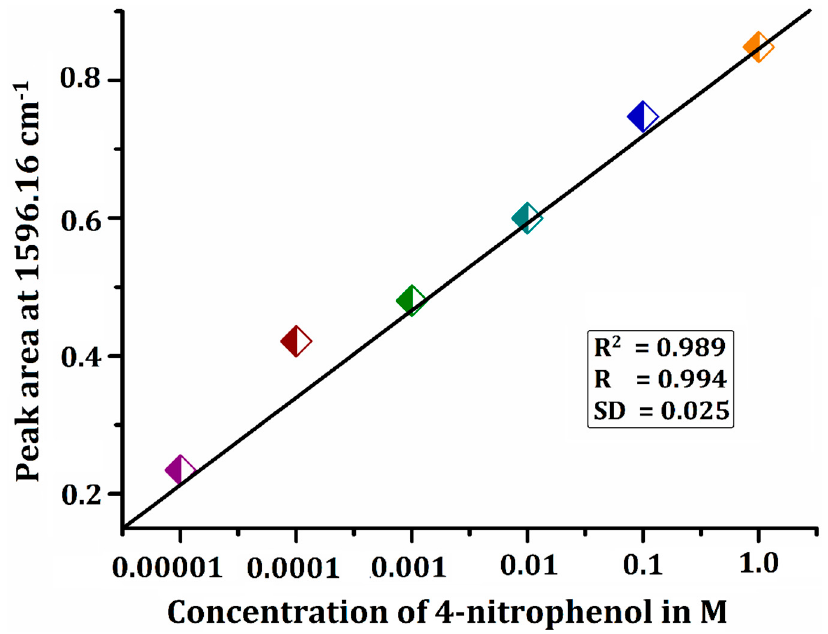
Figure 13. Calibration curve for the different concentration of 4-nitrophenol (M) against peak intensity or area at 1596.16 cm − 1 . Table 1. DRS-FTIR spectroscopic approach for 4-nitrophenol reduction catalyzed by CR-AgNCs in aqueous solution.